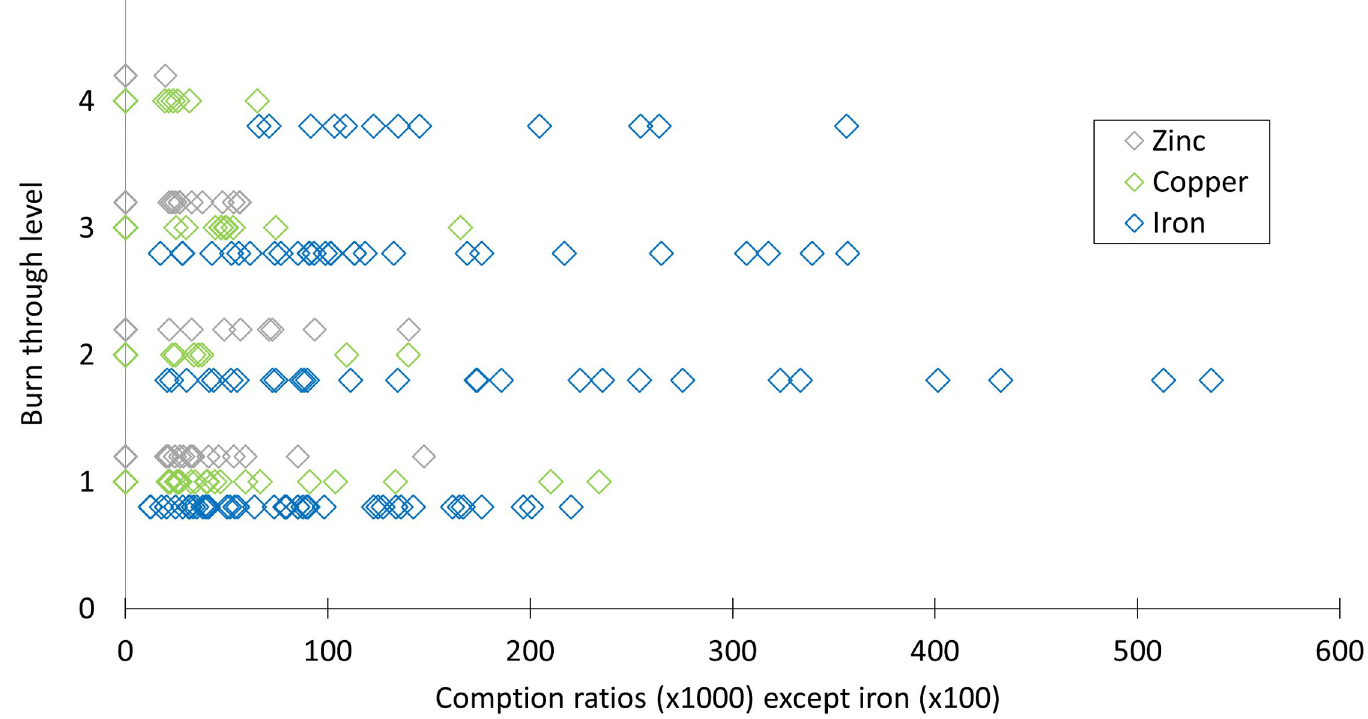
Fig 18. Level of burn through showing no correlation with semi quantitative XRF results. Data expressed as Compton ratios: [net peak area � 1000/Compton net peak area] except for iron where [net peak area � 100/Compton net peak area] in order to reduce the numbers for iron to improve legibility. All absent peaks were set to 0. In some cases the difference between a peak near background level or an absent peak is marginal and not always obvious. Absent peaks can simply mean present below limit of detection.